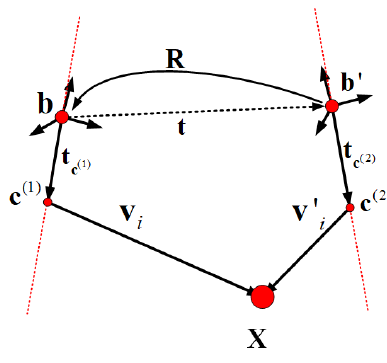
Figure 1: Geometry of the generalized relative pose problem for multi-camera systems. The unknowns are the transformation parameters between the two viewpoints b and b ′ , given by t Figure 2: Geometry of the axial camera relative pose problem as and R . The observation vectors v i and v ′ and the position of the a multi-camera system. The unknowns are the transformation i camera centers c (1) and c (2) with respect to b and b ′ , given by parameters between the two viewpoints b and b ′ , given by t t and t , respectively. and R . The observation vectors v i and v ′ and the position of c (1) c (2) i the camera centers c (1) and c (2) with respect to b and b ′ , given = k ′ n = [0 , 0 , − k ′ ] T , = k n = [0 , 0 , − k ] T and t by t c (2) c (1) respectively. The axial nature dictates that all camera centers to be on the same system axis, n (dashed red line) for each one of the viewpoints. Note that, b and b ′ must also lie on the axes of the